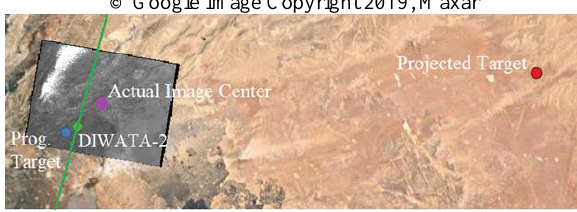
Figure 5. Damascus, Syria. Relative positions.